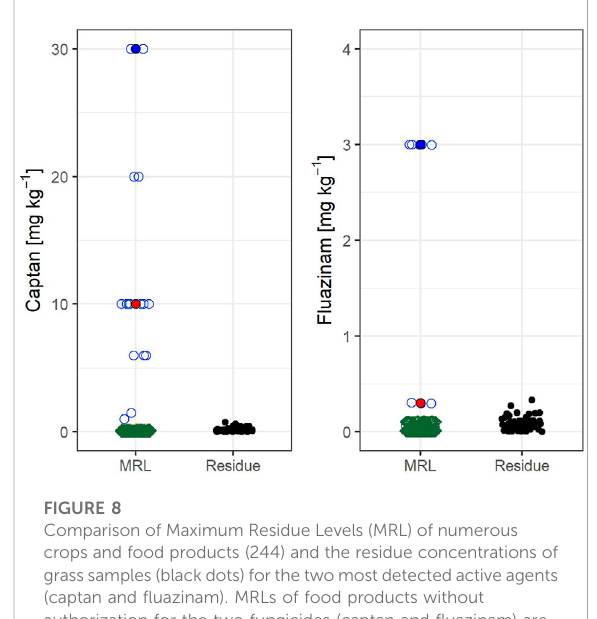
FIGURE 8 Comparison of Maximum Residue Levels (MRL) of numerous crops and food products (244) and the residue concentrations of grass samples (black dots) for thetwomost detectedactive agents (captan and fl uazinam). MRLs of food products without authorization for the two fungicides (captan and fl uazinam) are equal to the lower limit of quanti fi cation (LOQ) and given in green rectangles. Open circles represent the MRLs of food with